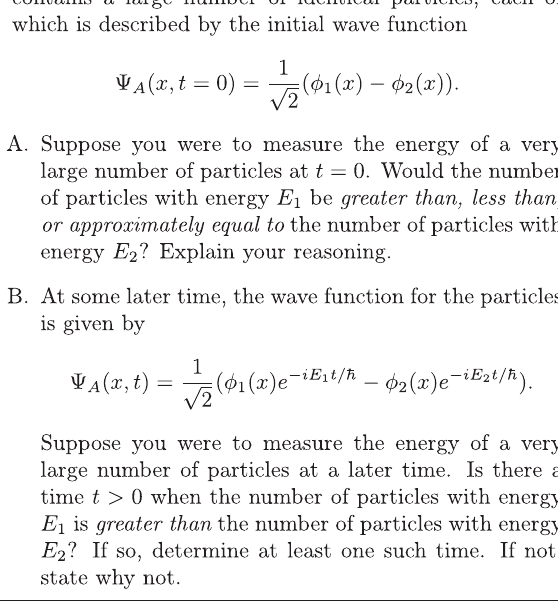
FIG. 1. A sequence of questions given after all instruction in the sophomore quantum mechanics course. Similar questions have been given to students at the junior and graduate levels.